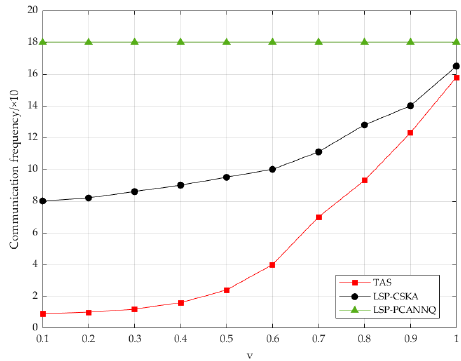
ff ect of moving speed on communication Figure 14. The effect of moving speed on communication frequency. Figure 14. The e